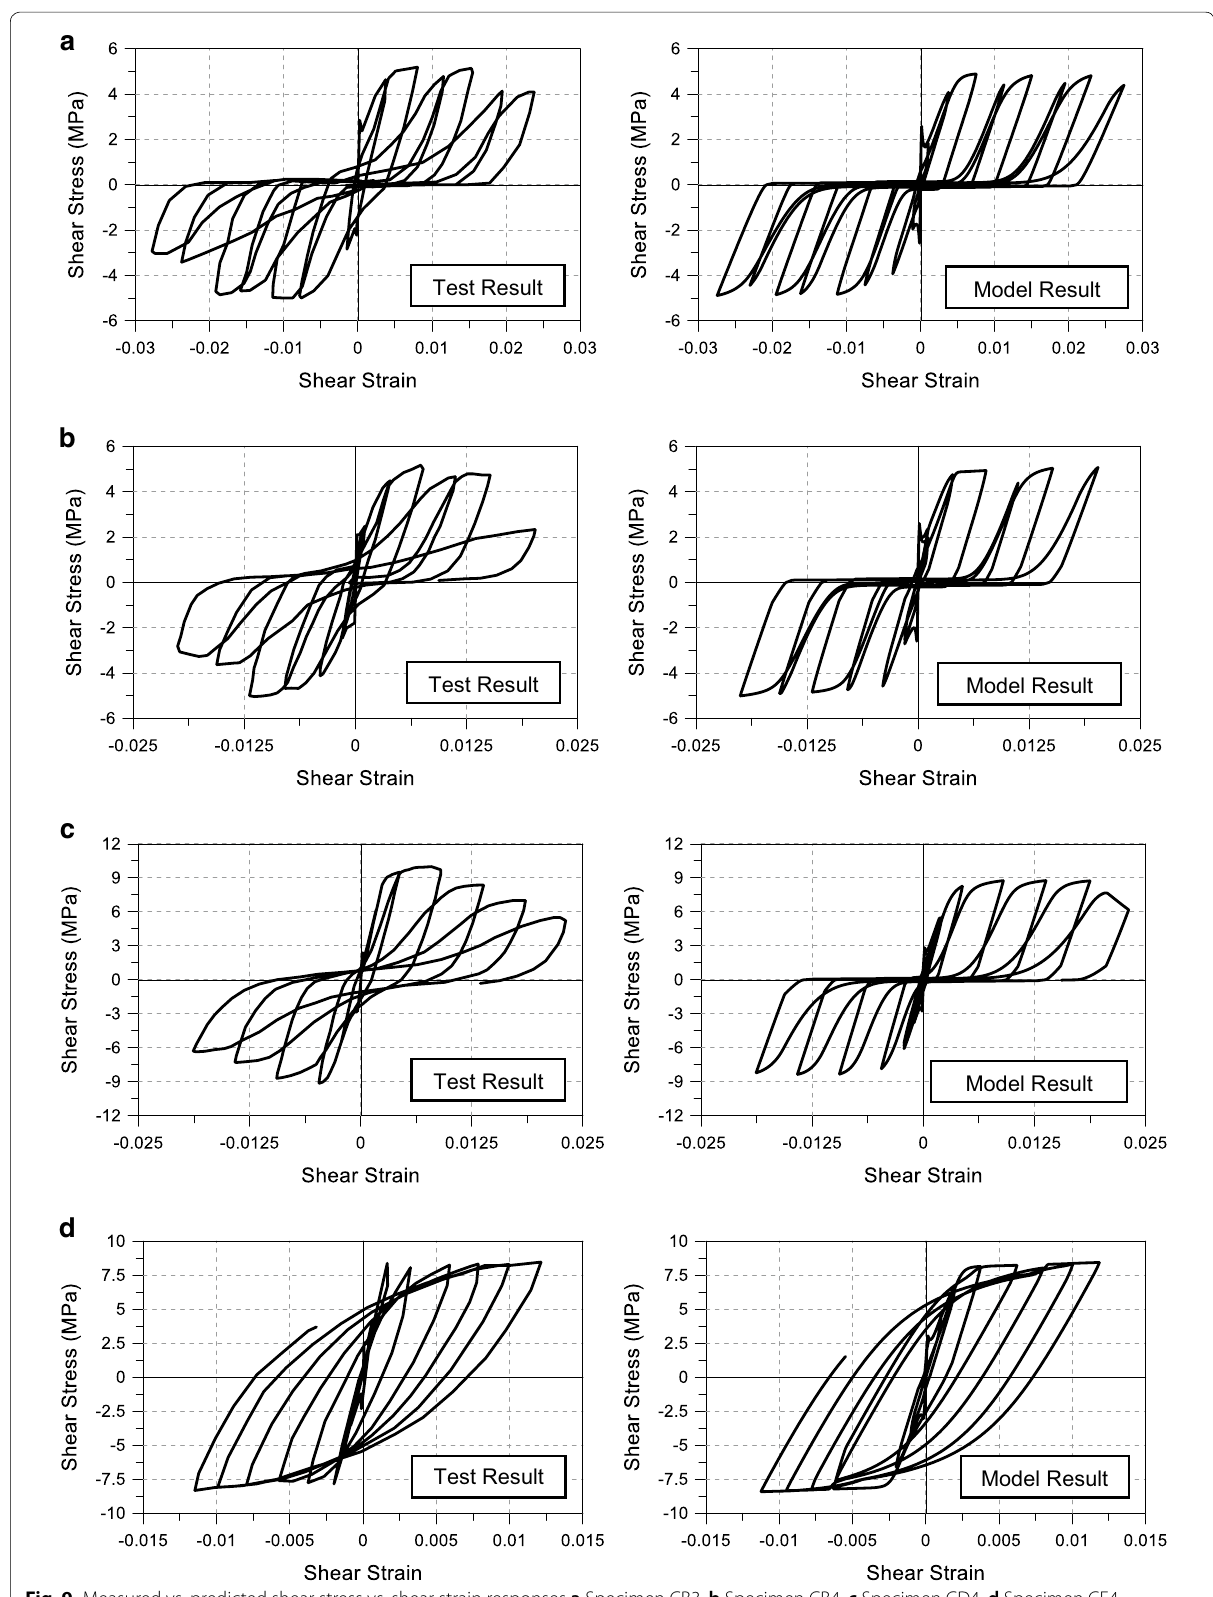
Fig. 9 Measured vs. predicted shear stress vs. shear strain responses a Specimen CB3, b Specimen CB4, c Specimen CD4, d Specimen